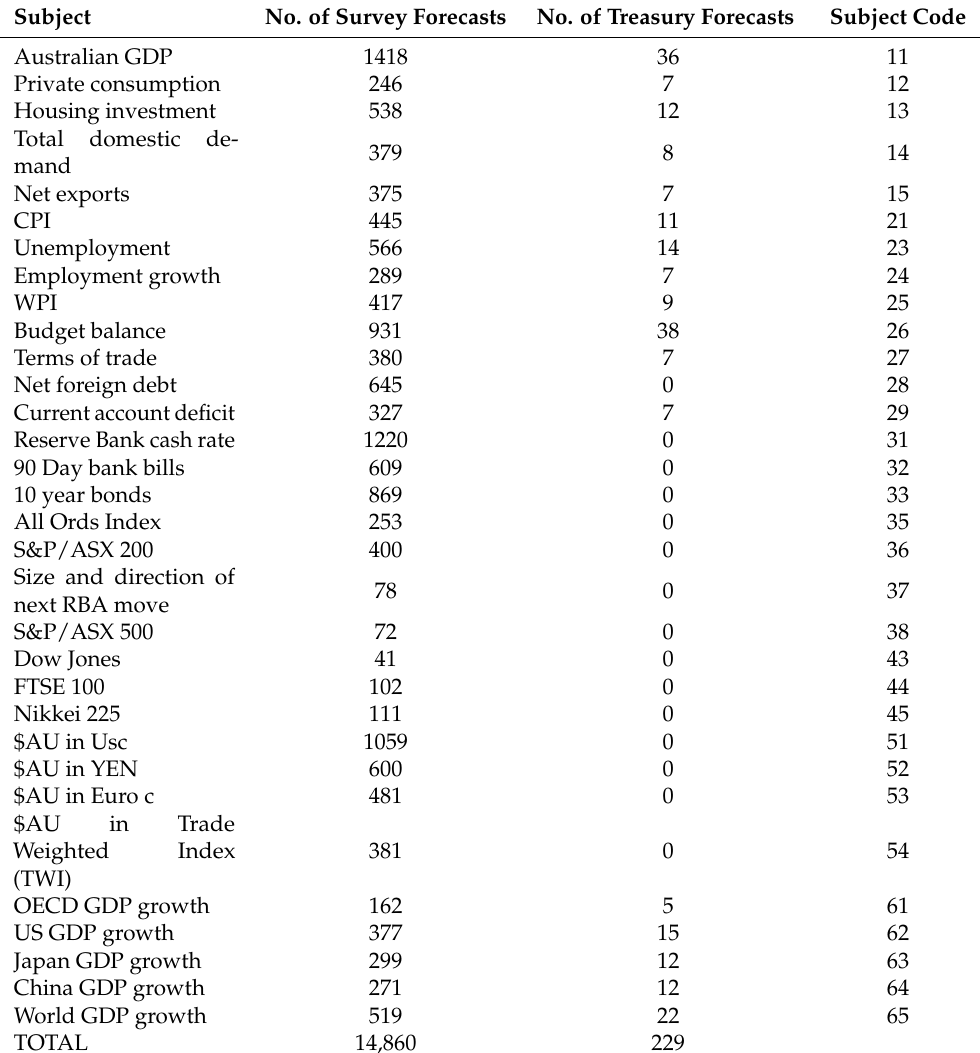
Table 1. The number of forecasts of different kinds appearing in the Fairfax Business Day survey of economists appearing between January 1996 and July 2016 and the corresponding forecasts made by